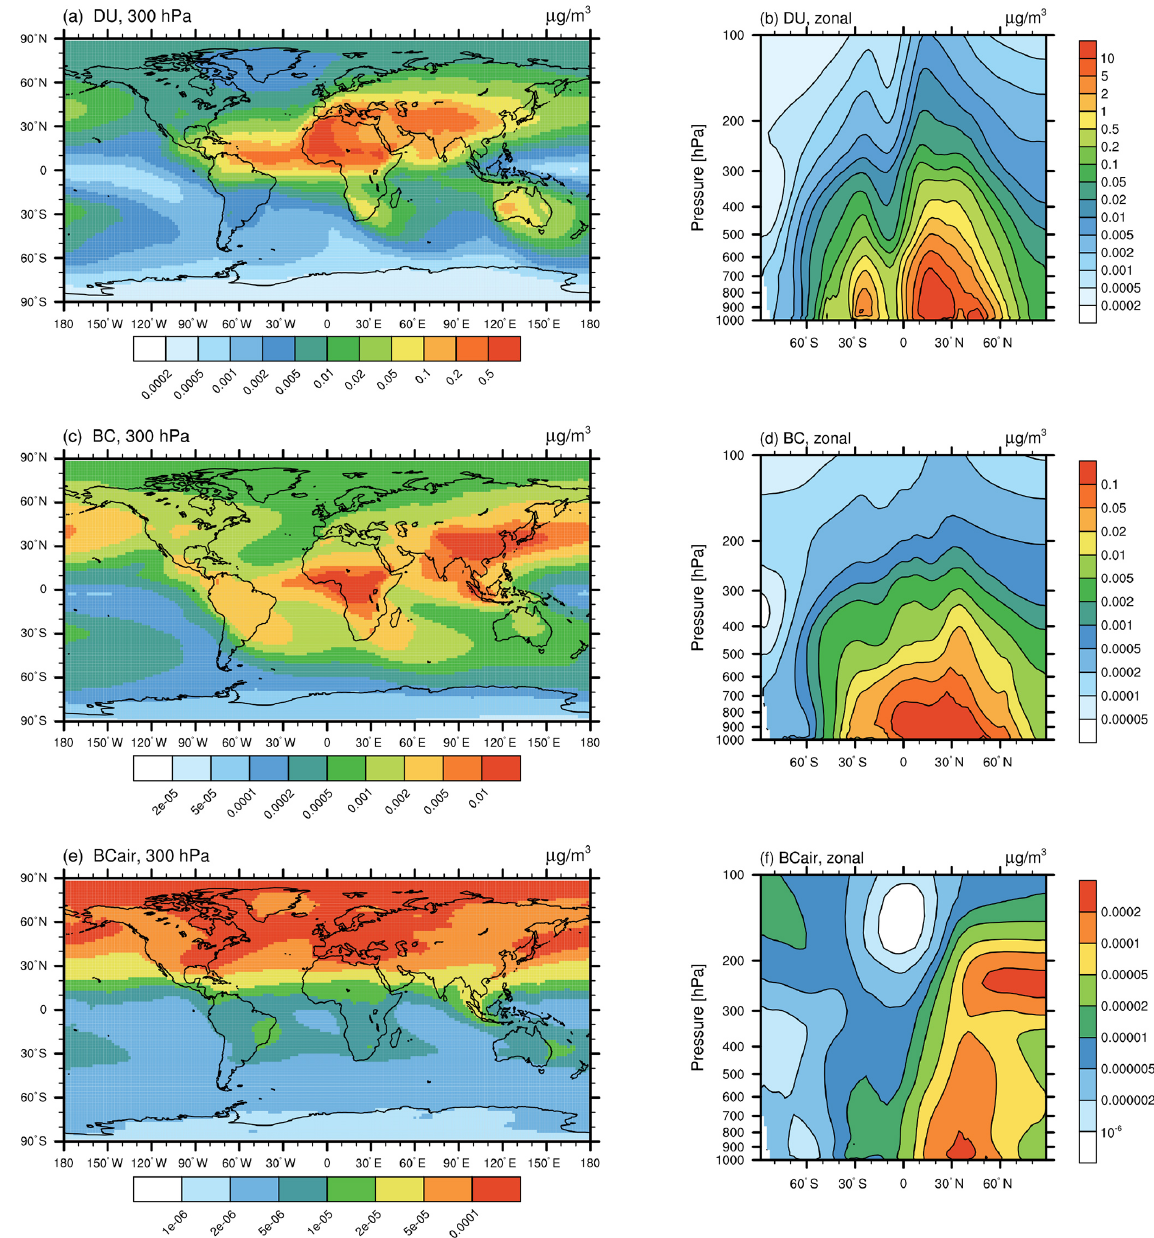
Figure 1. Global distribution of the mass concentrations of mineral dust (DU; a , b ), black carbon (BC; c , d ), and black carbon from aviation emissions (BCair; e , f ) in micrograms per cubic metre (µgm − 3 ), simulated with EMAC-MADE3 considering the multi-year average over the simulation period (2010–2019). Panels (a) , (c) , and (e) show the global distribution at the 300hPa pressure level, and panels (b) , (d) , and (e) show zonal means. Note the different scales in each